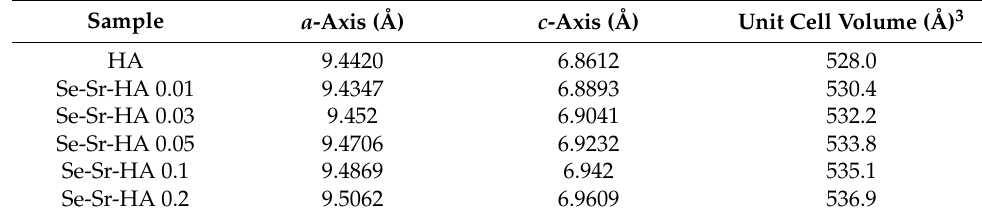
Table 1. Lattice parameters of HA and Se-Sr-HA with different Se/(Se + P) and Sr/(Ca + Sr).